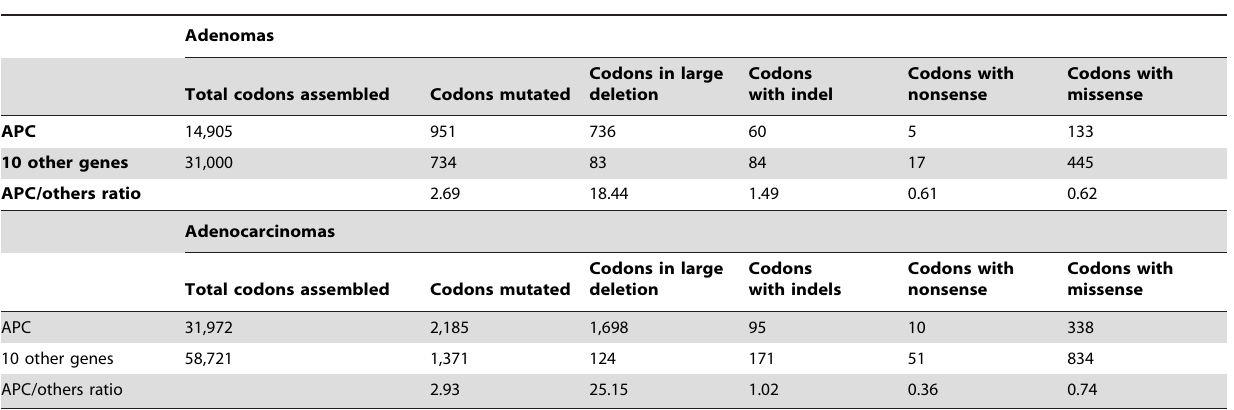
Table 2. Mutated codons of APC and other 10 genes in canine colorectal